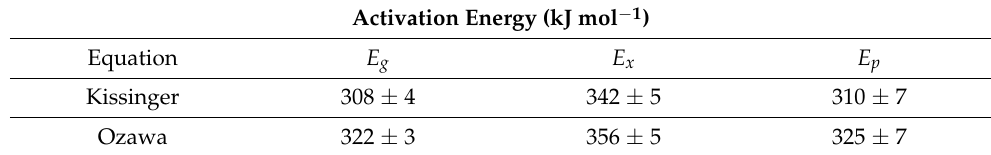
Table 2. The calculated activation energy of the Fe 68 Nb 6 B 23 Mo 3 metallic glass.